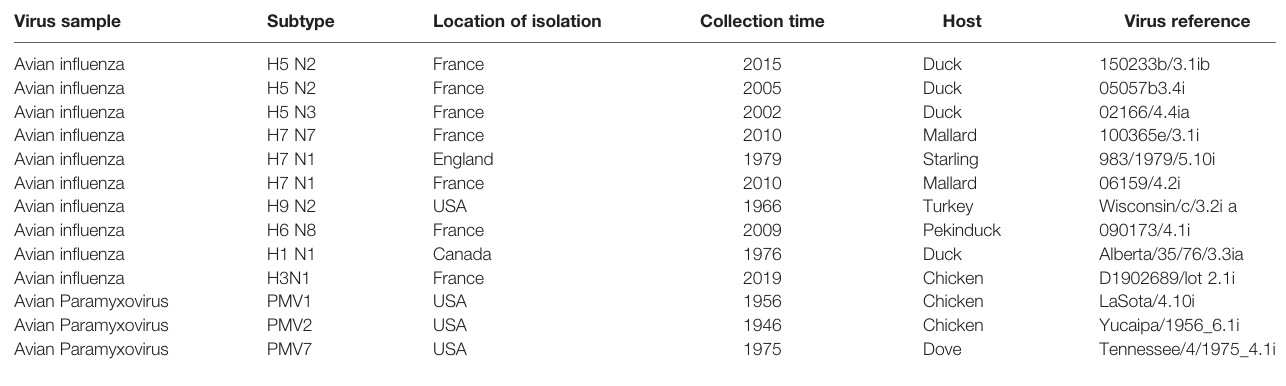
TABLE 1 | The list of Virus strains used in this